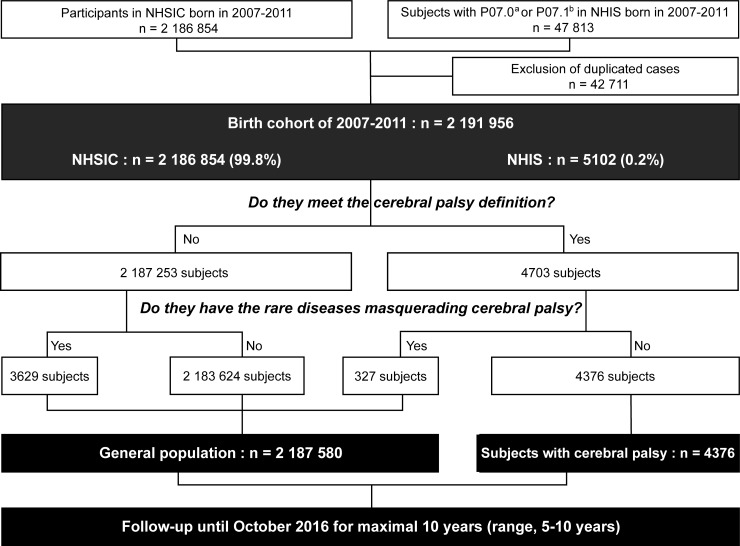
The flow diagram of development of the 2007 to 2011 birth cohort.NHSIC, the National Health Screening Program for Infants and Children; P07.0, the code of BW <1000 g by the Korean Classification of Diseases; P07.1, the code of 1000 g ≤ BW <2500 g in the Korean Classification of Diseases; NHIS, the National Health Insurance Service.